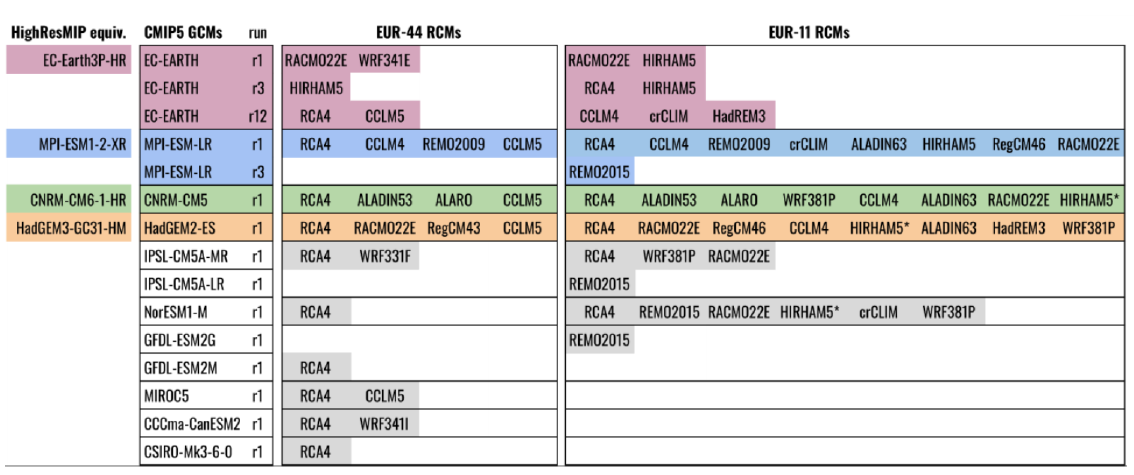
Table 2. Summary of historical EURO-CORDEX simulations used in this study. The first column indicates HighResMIP models of the same family as the CMIP5 GCM (second column) driving the RCMs. Matching colours show comparable HighResMIP GCMs and EURO- CORDEX RCMs. HIRHAM5* indicates several versions of this model were used. See Table S1 for the full list of EURO-CORDEX data used, including institutions and detailed RCM model version.